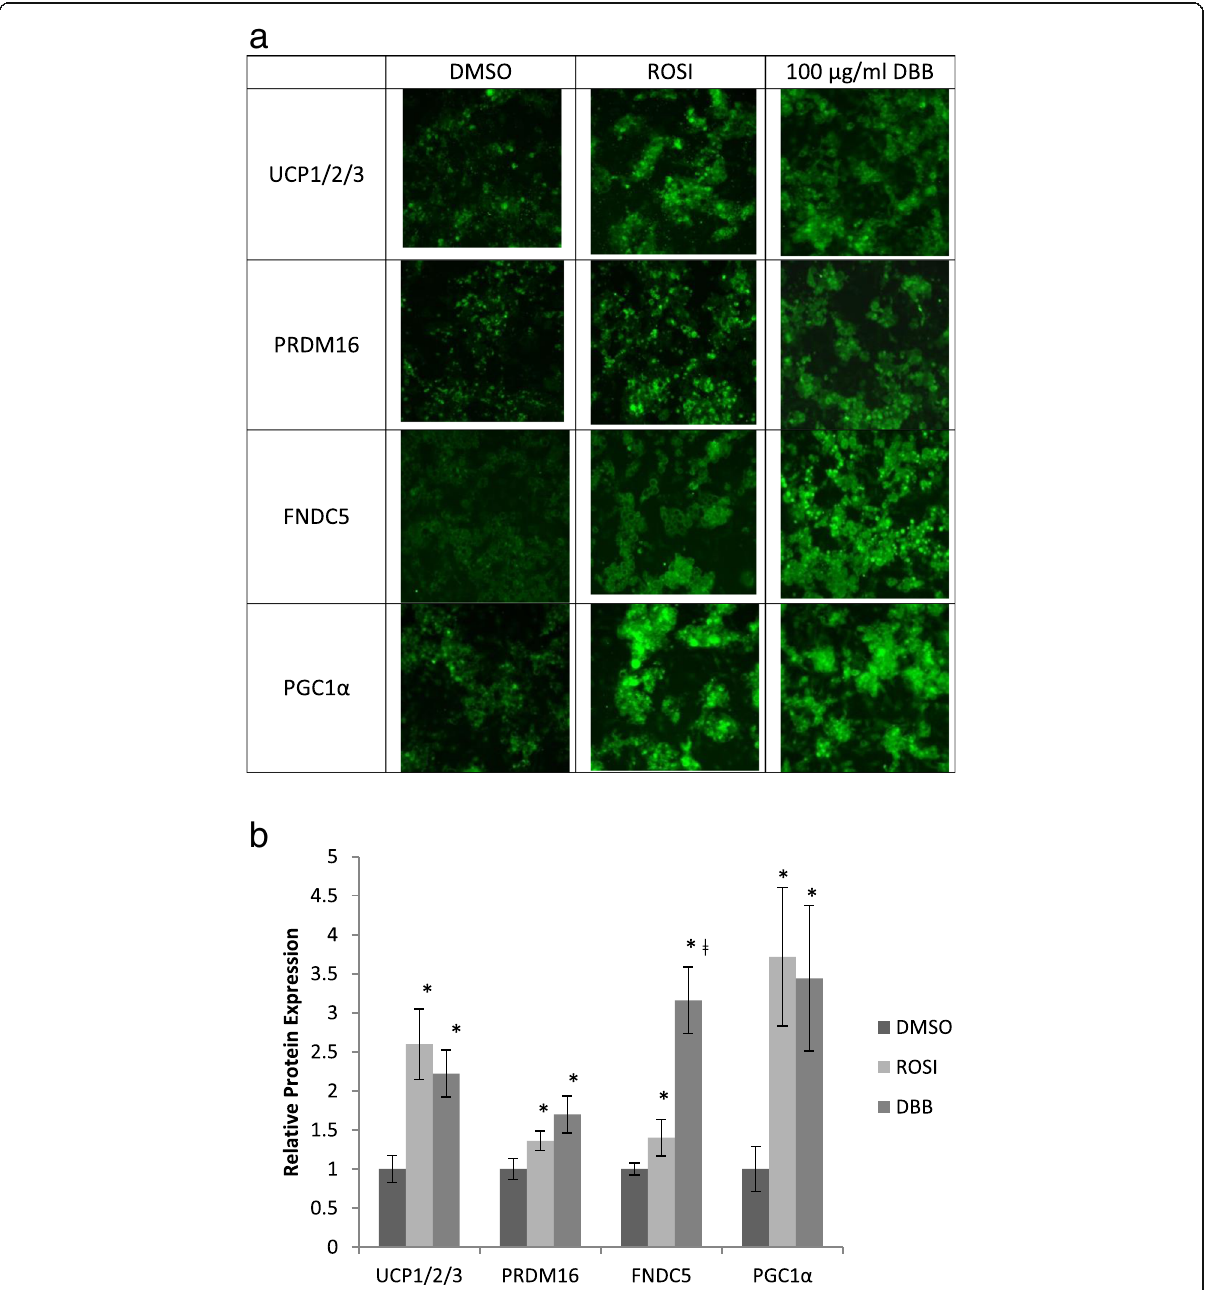
Fig. 3 3 T3-L1 adipocytes expressed browning markers after ROSI and DBB treatments. a Representation of 3 T3-L1 adipocytes images acquired using IN CELL 2200 Analyzer after 10 days of treatment with either 0.5% DMSO, 1 μ M ROSI or 100 μ g/ml DBB, followed by staining with primary antibody for specific protein and FITC-conjugated secondary antibody respectively. b Quantification of the relative proteins expressions as interpreted by the sum of fluorescent signals generated from the images of cells treated with either ROSI or DBB relative to treatment with DMSO (vehicle). * denotes statistically significance (ANOVA P < 0.05) as compared to the vehicle. ǂ denotes statistically significance (ANOVA P < 0.05) between ROSI and DBB for FNDC5